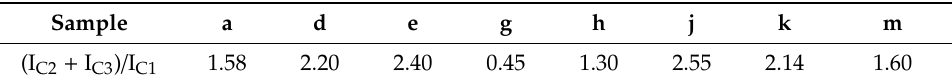
Table 1. Ratio of intensity (I) sum of C2, C3 (I C2 + I C3 ) to intensity the sum of C1 (I C1 ) for H 2 O, binary and ternary aqueous